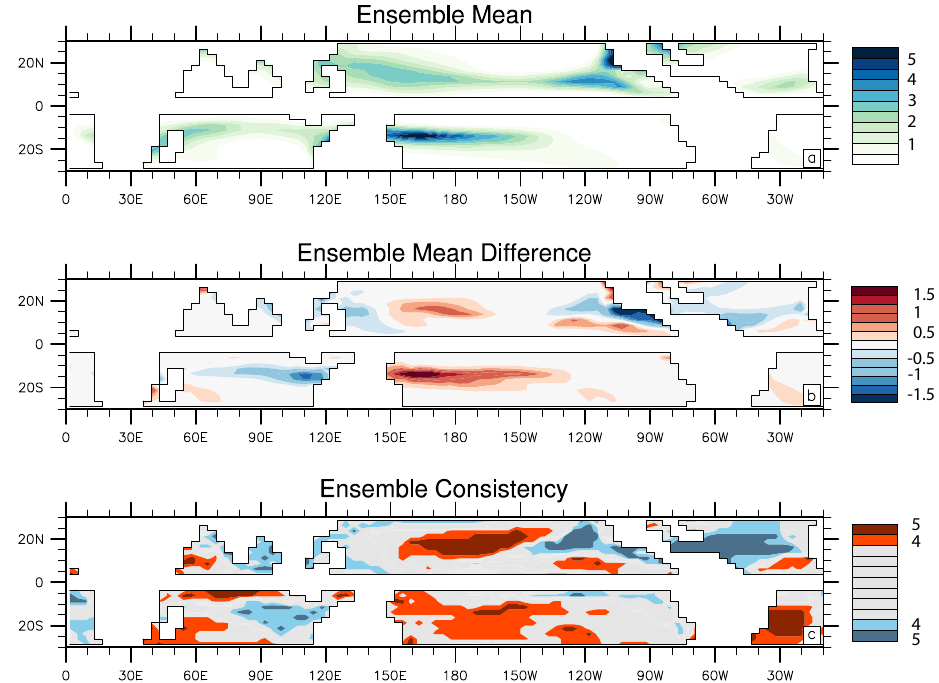
Figure 6. Panel (a) : LGM ensemble genesis potential index: panel (b) : LGM and preindustrial ensemble genesis potential index difference; and panel (c) : robustness of the ensemble signals, as indicated by the number of models agreeing with the direction of the change. Yellow and red denote areas for model agreement on positive sign change. Green and blue areas denote model agreement on negative sign change. White areas denote regions where less than four models agree. The Northern Hemisphere depicts JASO season, while the Southern Hemisphere depicts JFMA season. Units in (a) and (b) are 10 − 13 normalised occurrences m − 2 month − 1